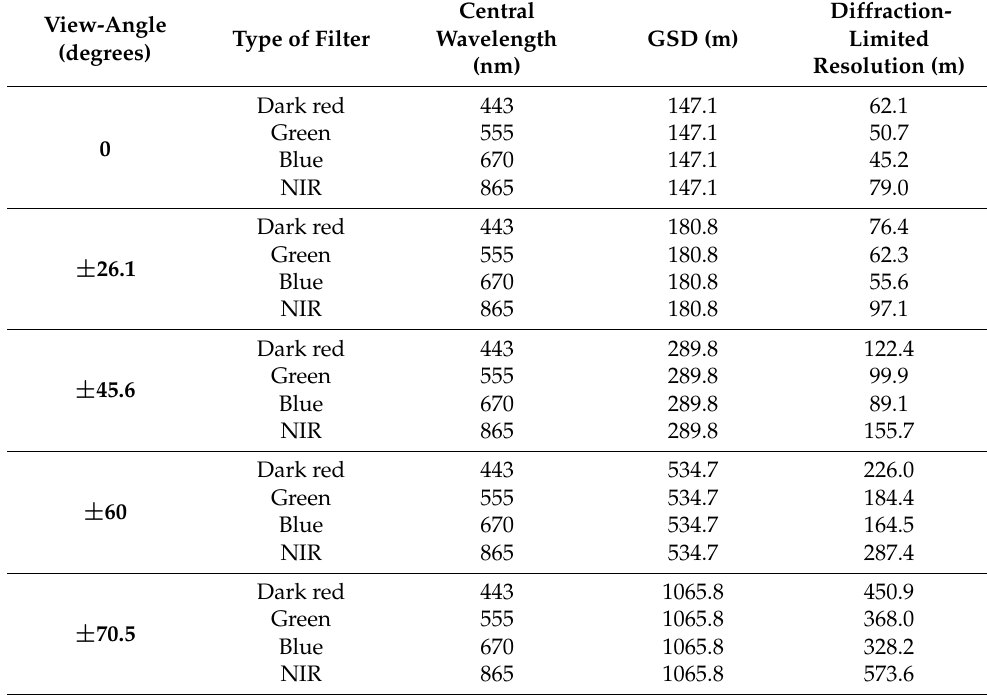
Table 7. Ground sample distance (GSD) and diffraction limited resolution at different wavelengths and view angles for 500 km orbital